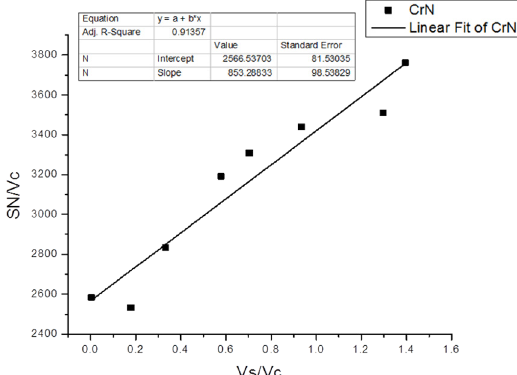
/ V versus SN/V Figure 13. V S C k and k in the perforating test C S